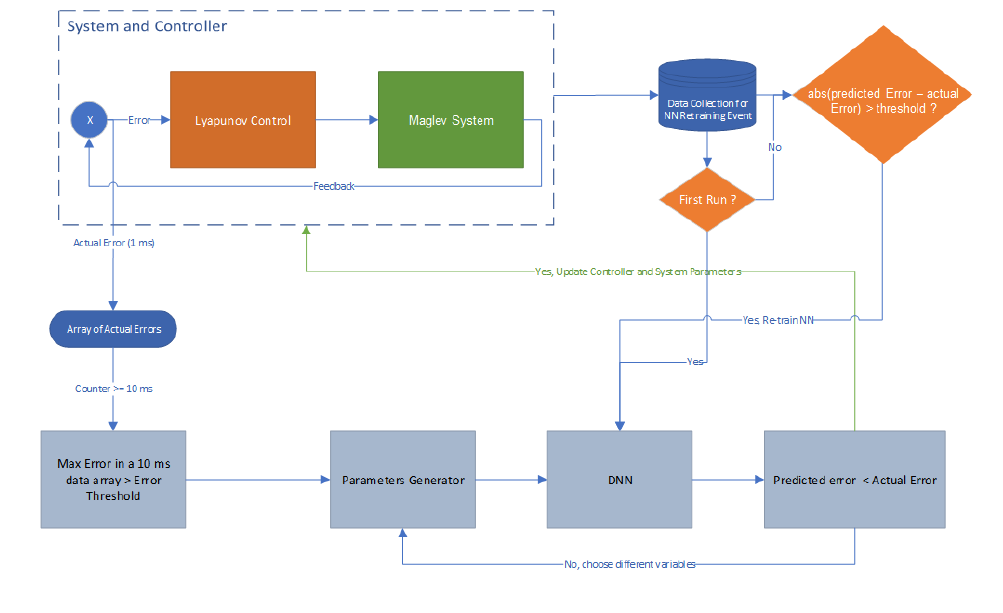
Figure 15. Network retraining flow